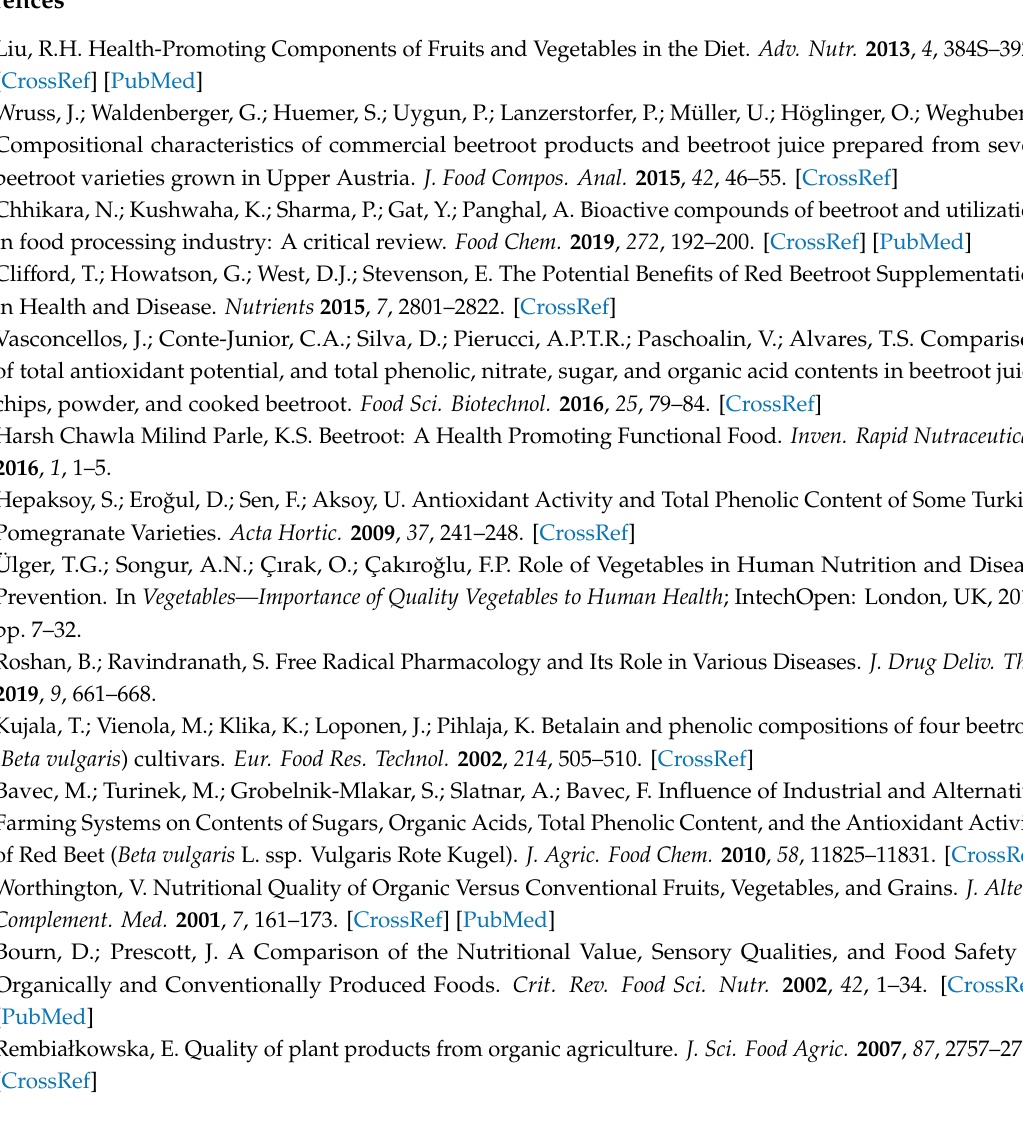
Supplementary Materials: The following are available online, Table S1: Mean values and ANOVA of results